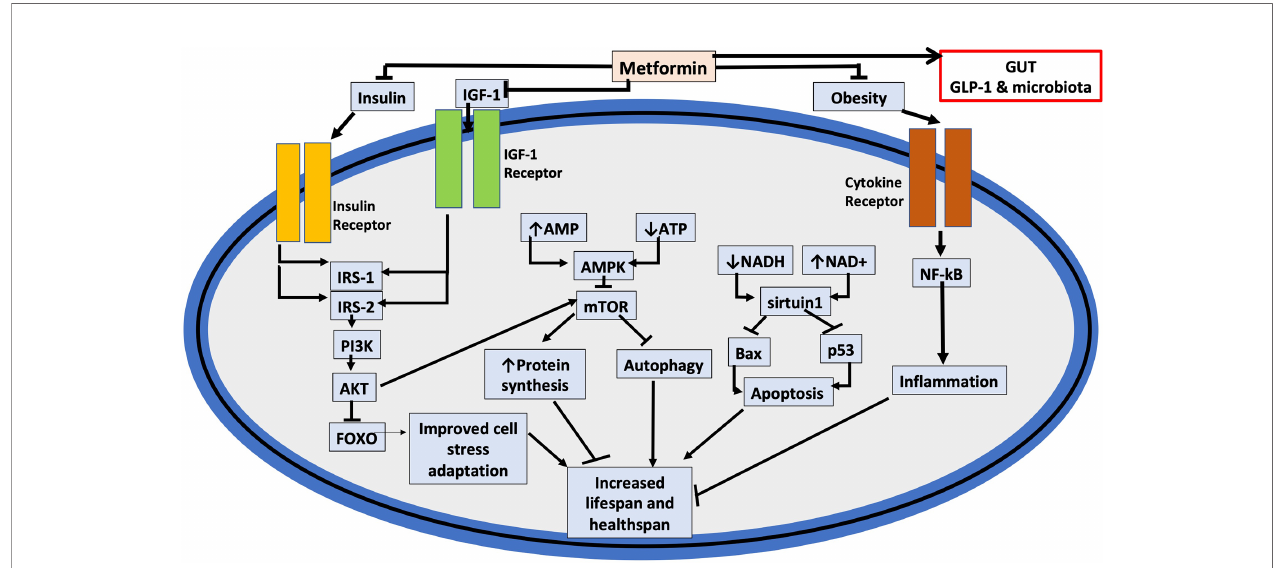
FIGURE 3 | Potential cellular targets for metformin that affect healthspan and lifespan. The fi gure depicts how metformin may affect cell aging and indicates a potential action in the gut where, prior to absorption, merformin modulates the microbiome as well as enhances release of glucagon-like factor 1 (GLP-1). Important links are also indicated to the insulin (IRS: Insulin Receptor Substrate) and insulin-like growth factor-1 (IGF-1) signaling pathways as well as to tumor suppressors including p53, and in fl ammation and cytokine signaling. (PI3K: Phosphatidylinositol 3-kinase); (AKT: protein kinase B); (FOXO: Forkhead Box O3); (SIRT1: NAD- dependent deacetylase sirtuin-1); (Bax: Bcl-2-associated X protein). As a result of metformin moderating the cellular signaling pathways mediated by insulin, IGF-1, and cytokines, both, healthspan and lifespan are increased. Metformin also, inhibits the in fl ammatory pathway and increases AMPK activation, which inhibits mTOR, a primary target for cell aging modulation. In fl ammation, apoptosis, autophagy, cell survival, and protein synthesis are all affected by these mechanisms and are all linked to accelerated